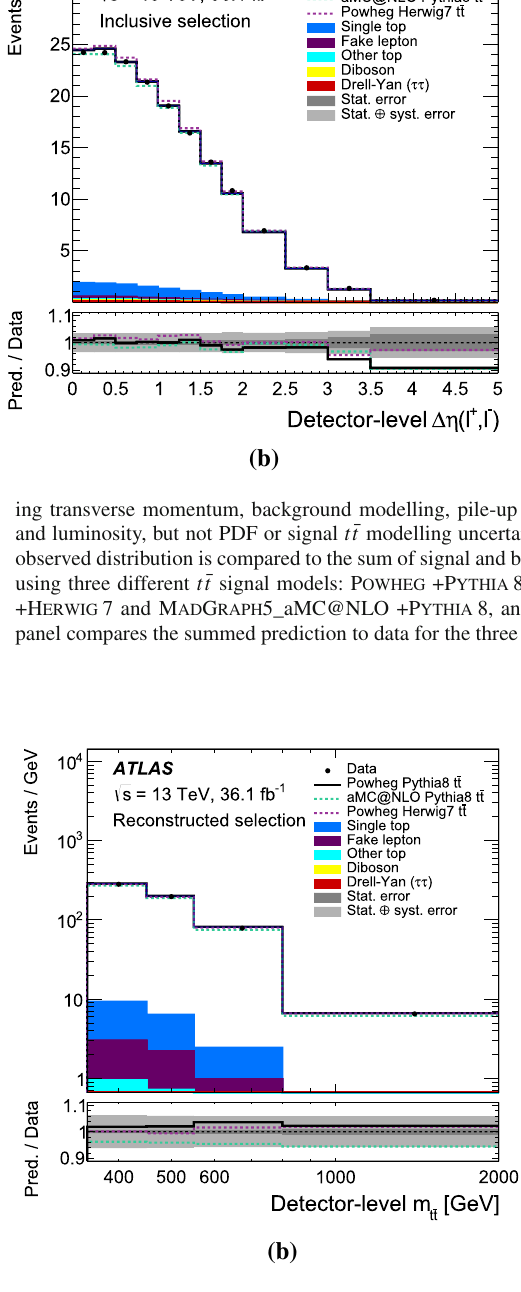
Fig. 3 Kinematic distributions for a (cid:3)φ and b m t ¯ t after the require- mentofatleasttwo b -taggedjetsandNeutrinoWeighting(reconstructed selection). The highest bin in b also contains events that are above the x -axis range. The dark uncertainty bands in the ratio plots represent the statistical uncertainties while the light uncertainty bands represent the statistical and systematic uncertainties added in quadrature. The systematic uncertainties include contributions from leptons, jets, miss-